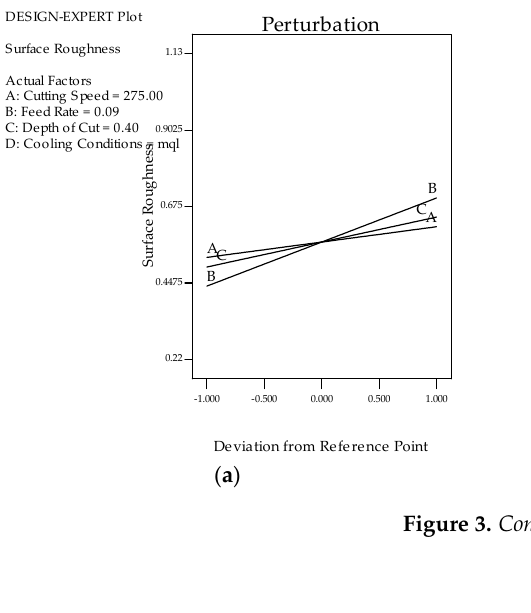
Figure 2. Results ( a ) MQL and vortex tube-assisted MQL(VMQL) comparisons of R a , ( b ) MQL, and VMQL comparisons of F c , ( c ) MQL and VMQL comparisons of VBmax , and ( d ) MQL and VMQL comparisons of cutting power ( P ).